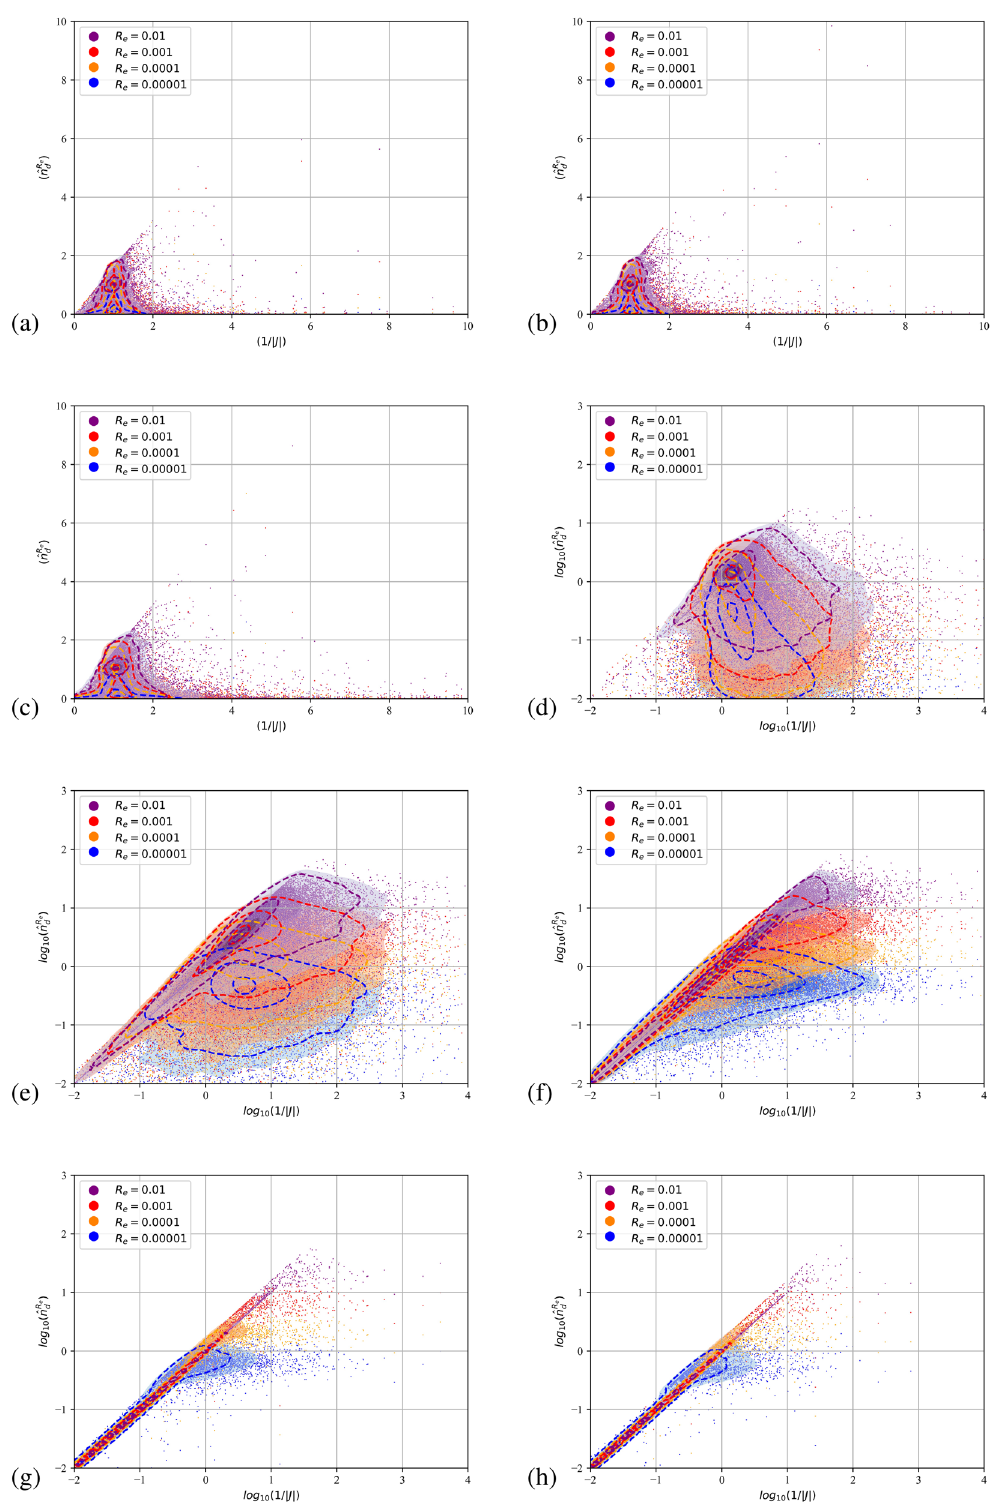
Figure 6. Scatter plot of the filtered FLA2 number density versus 1/ J . Colours correspond to the filtering length. Dashed iso-lines correspond to the kernel density estimation at levels 10% 50% and 90%. Case C3DN4. T = 8 ms. ( a – h ) D d = 0.5 – 100 µ m. ( d – h ) are presented in logarithmic